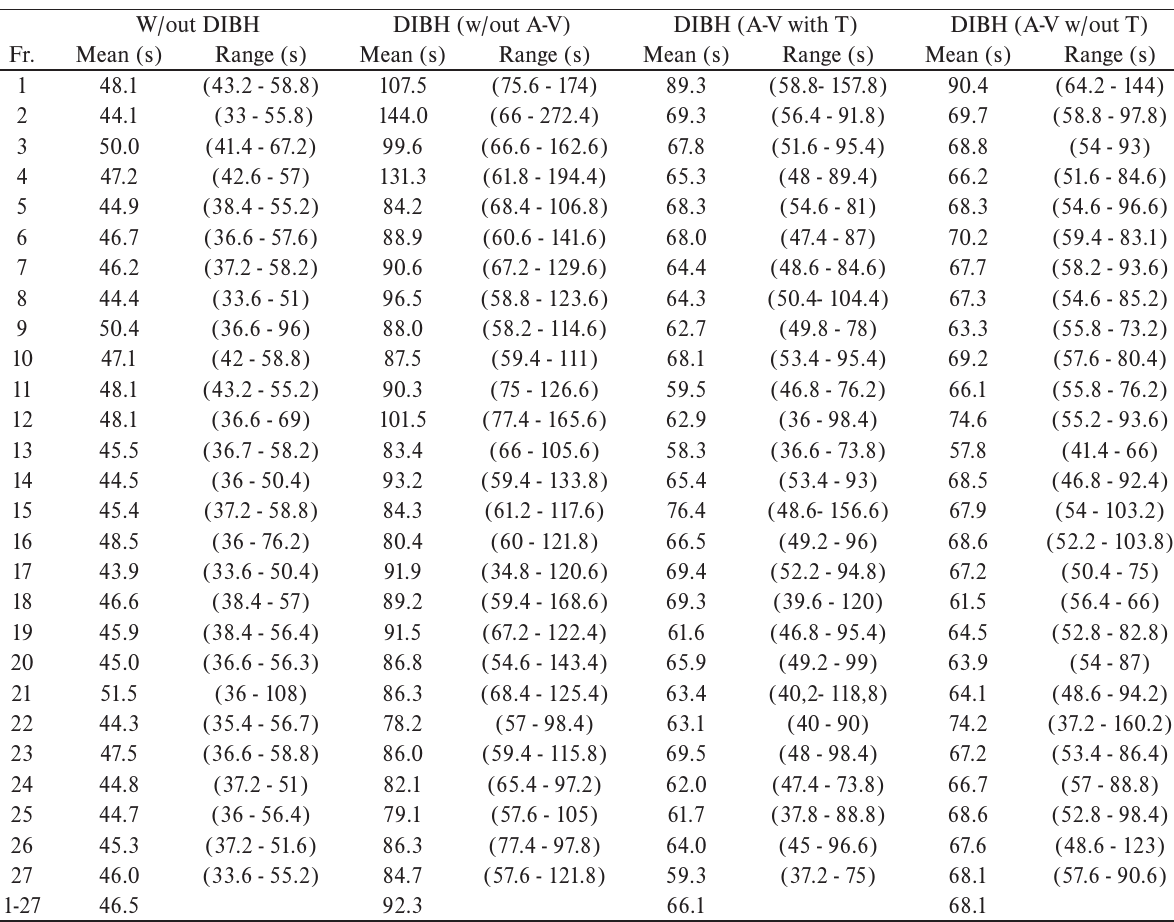
Table 1. Treatment times for each fraction related to